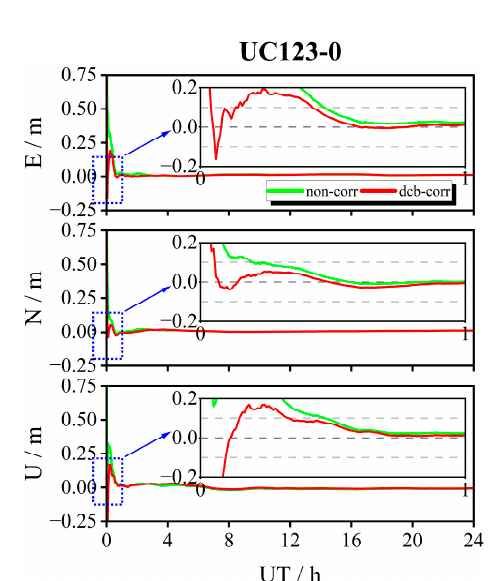
Figure 10. Positioning errors of UC123-0 at AREG station; 24-h time series.